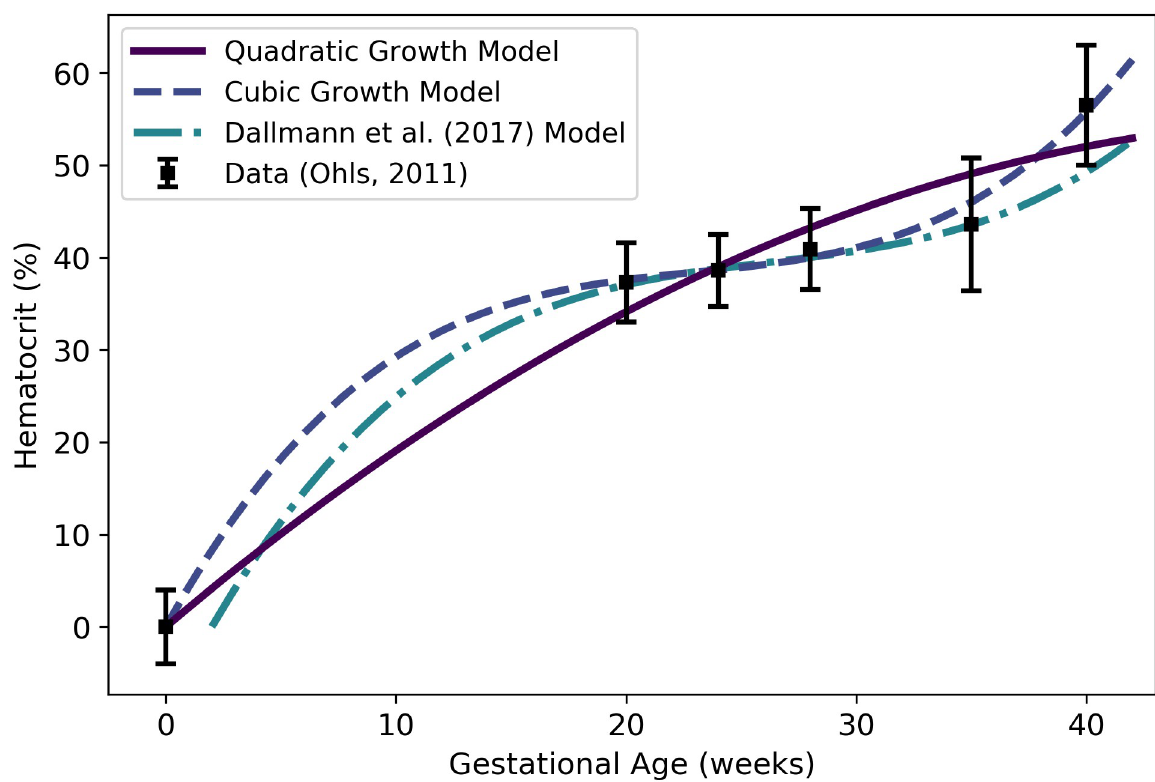
Fig 29. Fetal hematocrit vs. gestational age. The quadratic growth model (solid line) given by Eq 58 was selected as the most parsimonious model in our analysis, but the cubic growth model given by Eq 59 gives a better visual fit to the data while yielding only a slightly (0.8%) larger AIC score. We calibrated our models using the data curated by Ohls [41]. Dallmann et al. [3] calibrated their model with different